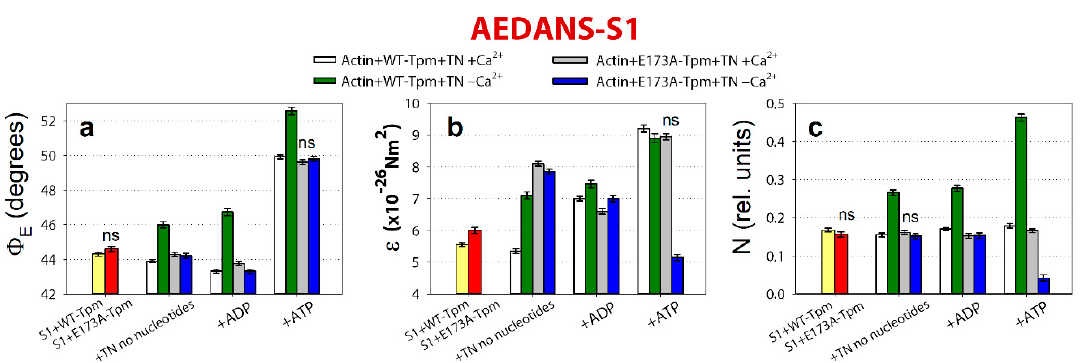
Figure 7. The effect of troponin and Ca 2+ on the values of Φ E ( a ), ɛ ( b ) and N ( c ) of the polarized fluorescence of N-(iodoacetaminoethyl)-1-naphthyl-amine-5-sulfonic acid (1,5-IAEDANS) bound to S1 (AEDANS-S1), in the presence of WT-Tpm or E173A-Tpm was revealed in glycerol-skinned fibres under conditions simulating the sequential steps of the actomyosin ATPase cycle. The data represent the mean values for 5–7 fibres for each experimental condition. The Φ E , ɛ and N values in the absence of troponin and in the presence of Ca 2+ and nucleotides are significantly altered by the E173A mutation in Tpm ( p < 0.05). Statistically insignificant differences in the values of Φ E , ɛ and N between the WT and mutant Tpms are indicated by the symbol “ns”. Error bars indicate ±SEM.